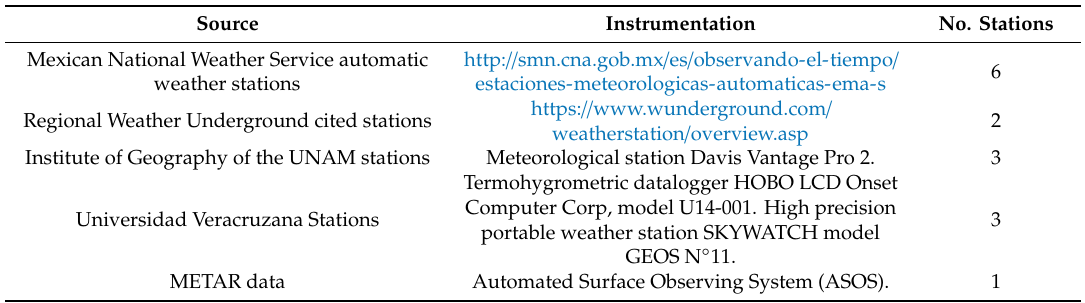
Table 1. Additional sources of meteorological observations of wind speed and